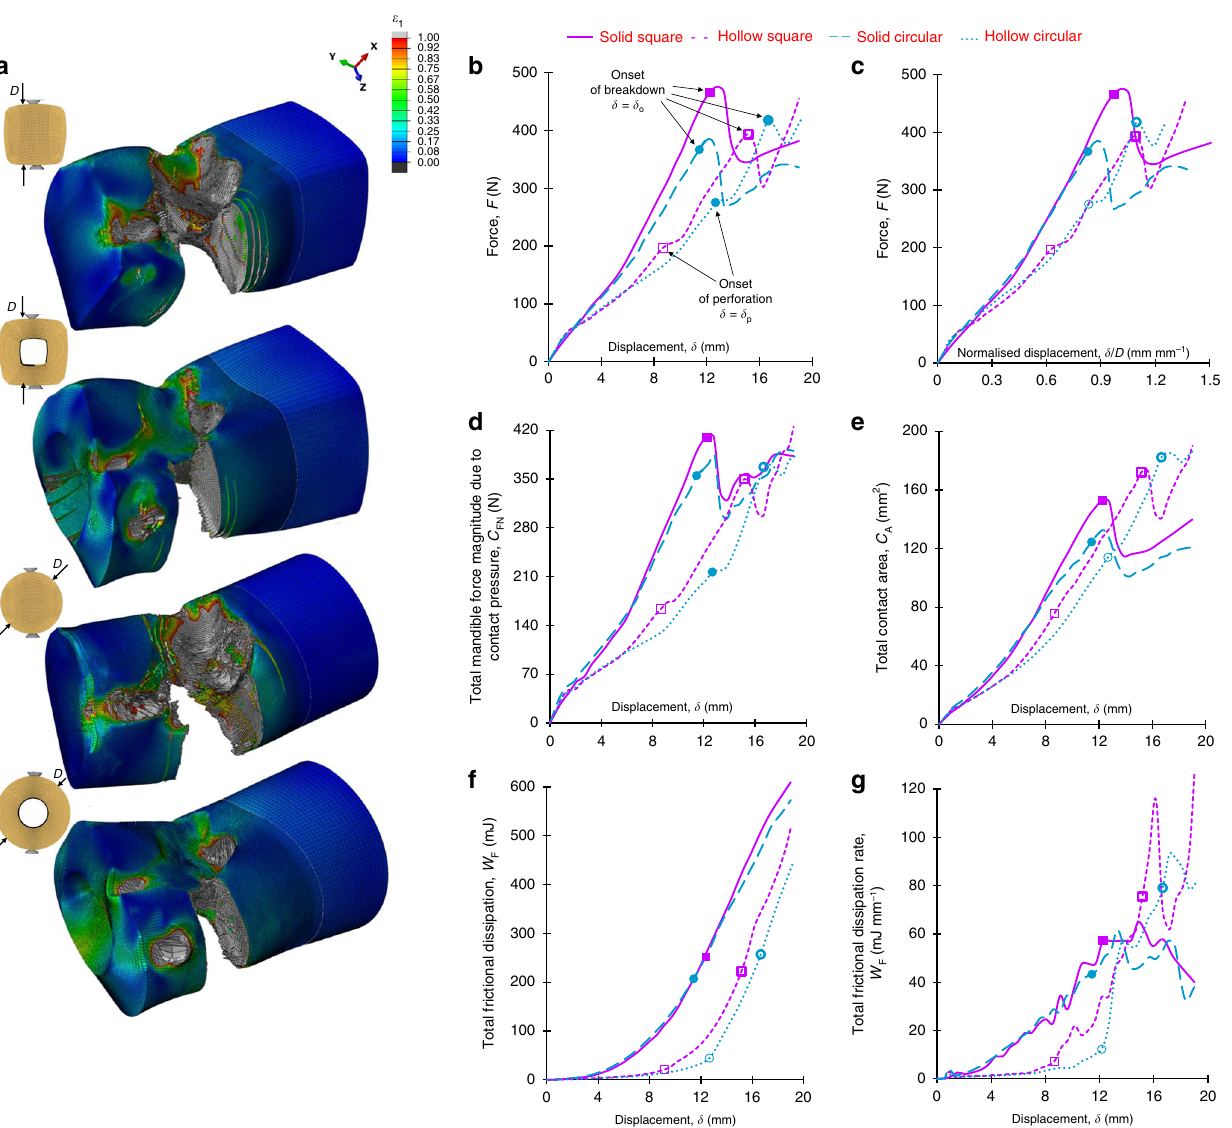
Fig. 5 Summary of cleaning ef fi cacy Finite Element results. Four food geometric pro fi les, namely solid square, hollow square, solid circular and hollow circular, are compared in terms of: a maximum principal strain contours at maximum bite displacement 19 mm (food cross sectional pro fi les are shown on the left), b force-displacement response, c force normalised over the food diameter versus displacement response, d total mandible force due to contact pressure versus displacement response, e teeth-food total contact surface area versus displacement response, f total frictional dissipation versus displacement response and g total frictional dissipation rate versus displacement response. In panel a from top to bottom the pro fi les have respective effective diameters 12.6 mm, 13.9 mm, 13.8 mm and 15.2 mm, such that a common cross sectional area of 150 mm² is satis fi